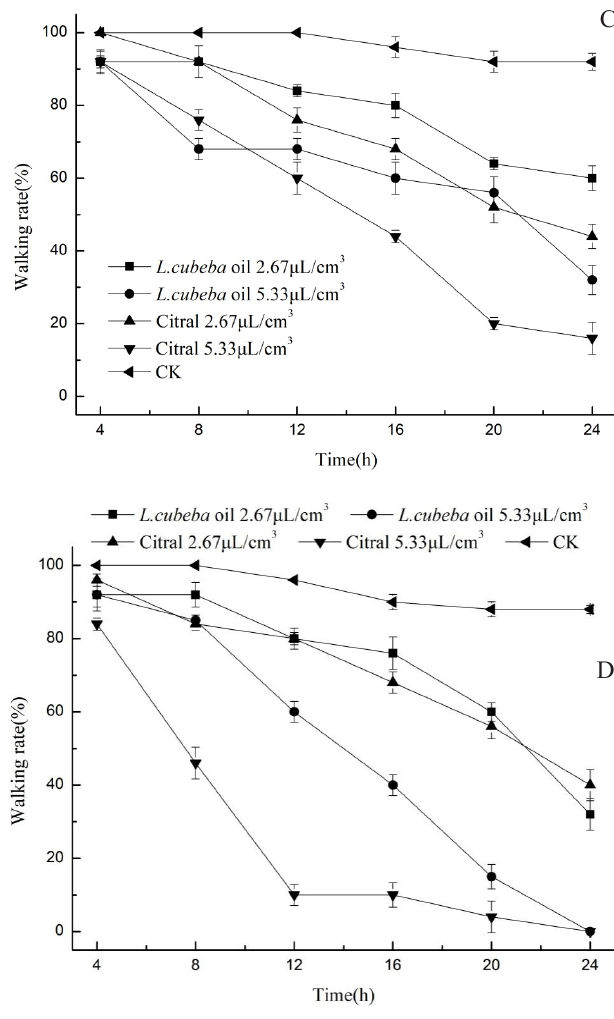
Fig 3 . Effects on walking ability of workers (C: macroergate, D: microergate) after treating for 24 hours of Litsea cubeba oil and citral.